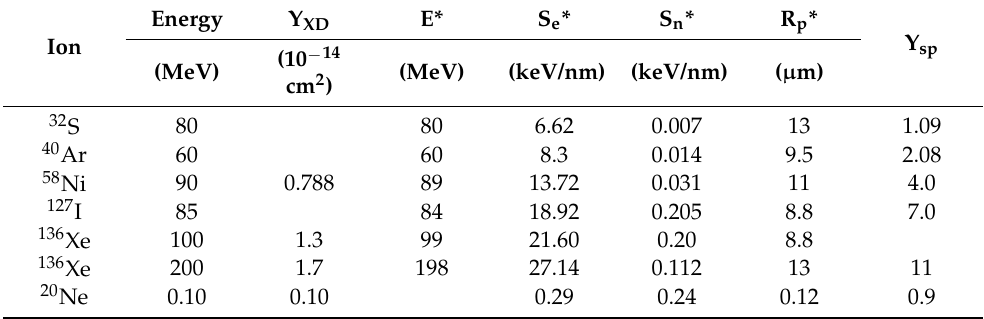
Figure 3. XRD intensity normalized to as-deposited films of ZnO as a function of ion fluence for 90 MeV Ni ( ∆ , +), 100 MeV Xe (o, x) and 200 MeV Xe ( (cid:3) ) ions. Diffraction planes are (002) at ~34 ◦ ( ∆ , o, (cid:3) ) and (100) at ~32 ◦ (+, x). Linear fit is indicated by dashed lines. An estimated error of XRD intensity is 10%. Table 3. XRD data of ZnO films. Ion, incident energy (E in MeV), XRD intensity degradation (Y XD ), E* = E − ∆ E (energy loss in carbon foil of 100 nm) (MeV) and electronic (S e *) and nuclear (S n *) stopping powers in keV/nm and projected range R p * ( µ m) at E* calculated using SRIM2013. Sputtering yield Y sp from [54]. Sputtering yield by 100 keV Ne ion is also